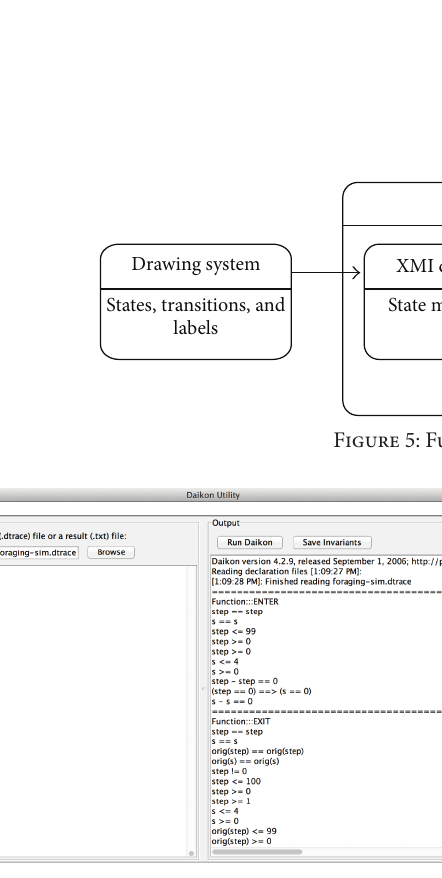
Figure 6: Daikon invariant